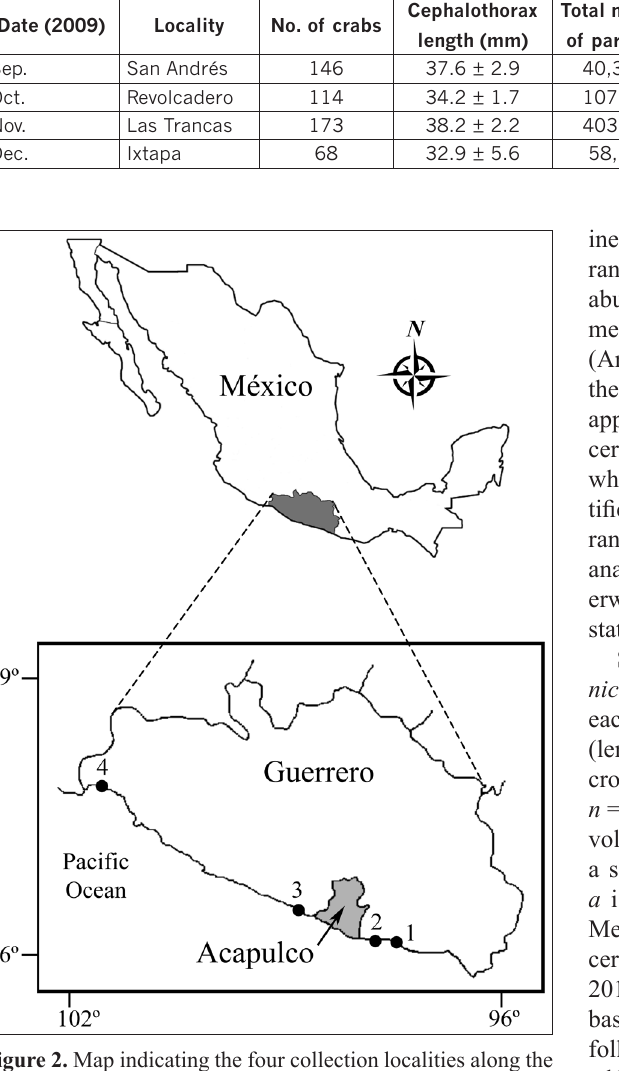
Figure 2. Map indicating the four collection localities along the Pacific coast of Guerrero. 1. San Andres; 2. Revolcadero; 3. Las Trancas; 4.